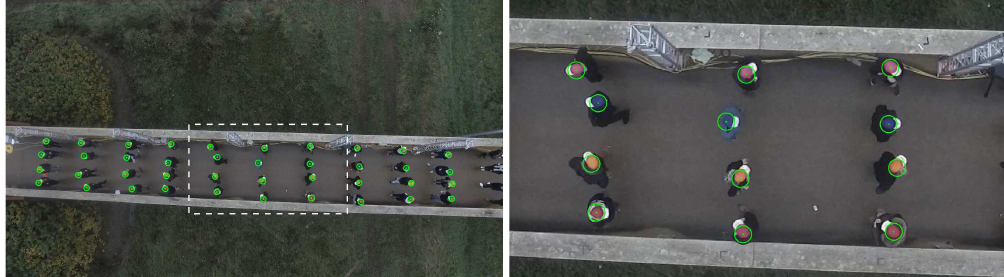
Figure 17. Conceptual illustration of the propagation of random measurement noise: an error in the image-plane results in an error in world coordinates for ( left ) mono and ( right ) stereo conversion. The PDF of the detections is represented by the shaded area on the image planes while the PDF of the obtained world coordinate is given by the shaded area on the plane π . In case of the stereo conversion, the PDF is projected onto the plane π as to only retain the horizontal uncertainty.